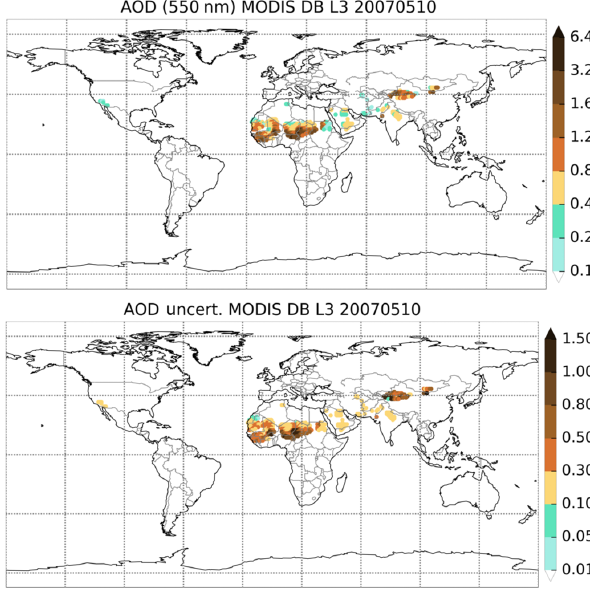
Figure 2. Aerosol optical depth (top) and its associated observation error (bottom) for 10 May 2007 for the NRL MODIS Level 3 prod- uct after the application of a filter for dust-dominated conditions.